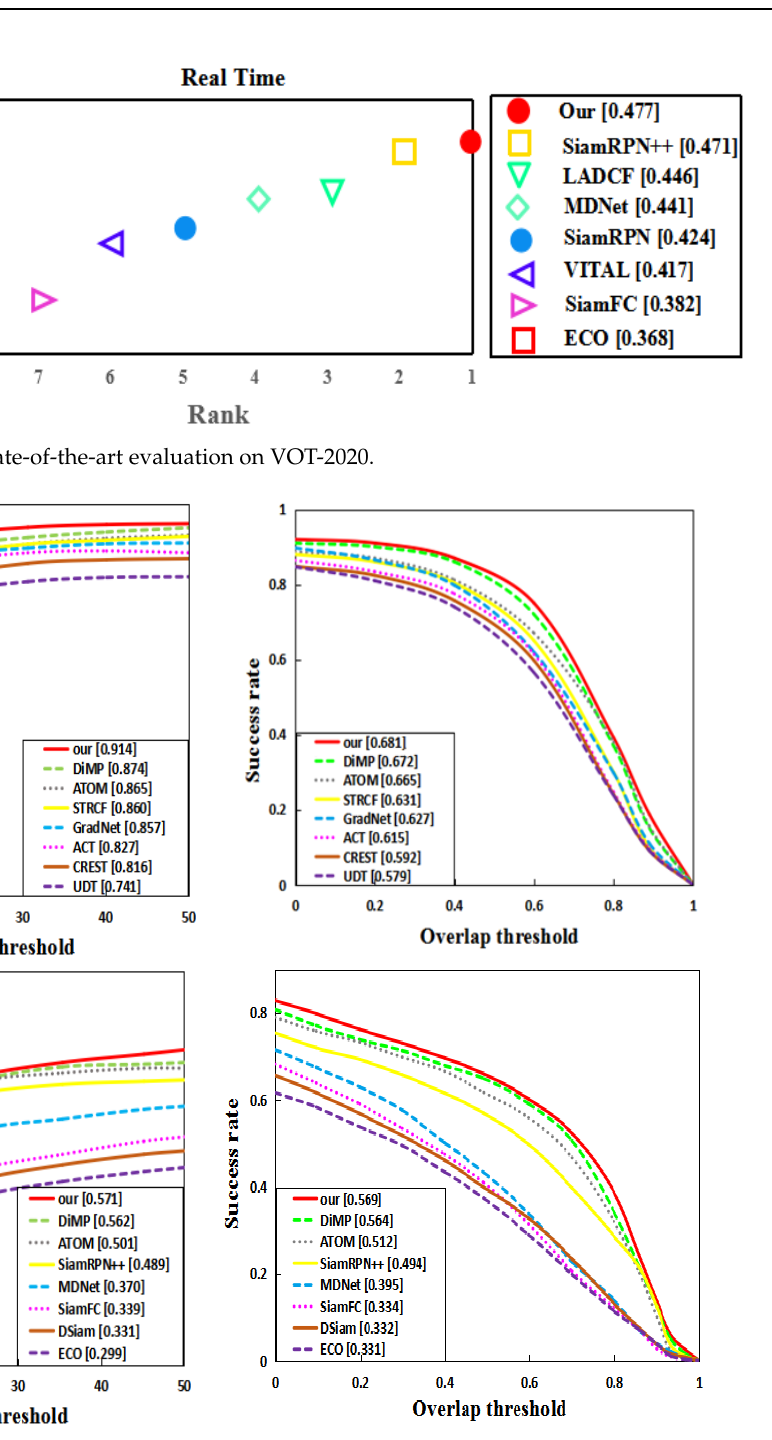
Figure 4. Success plot and precision plot of OTB-100 ( Top ) and LaSOT ( Bottom ).